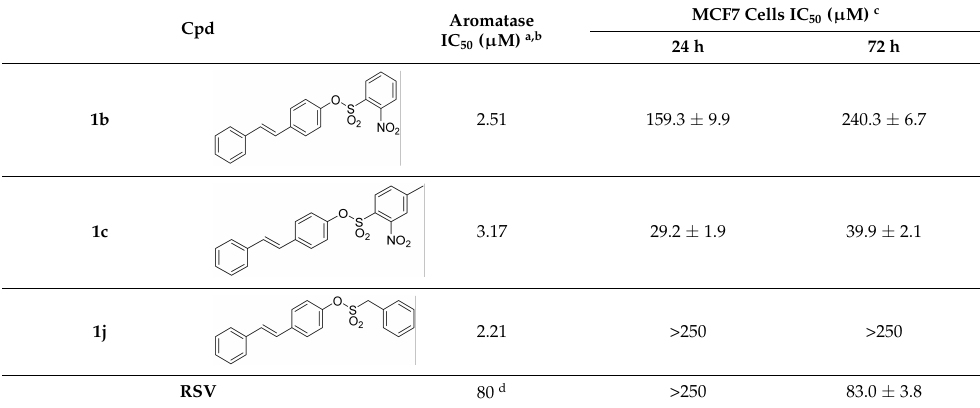
Table 1. In vitro human aromatase inhibition profile for 1b , 1c , and 1j